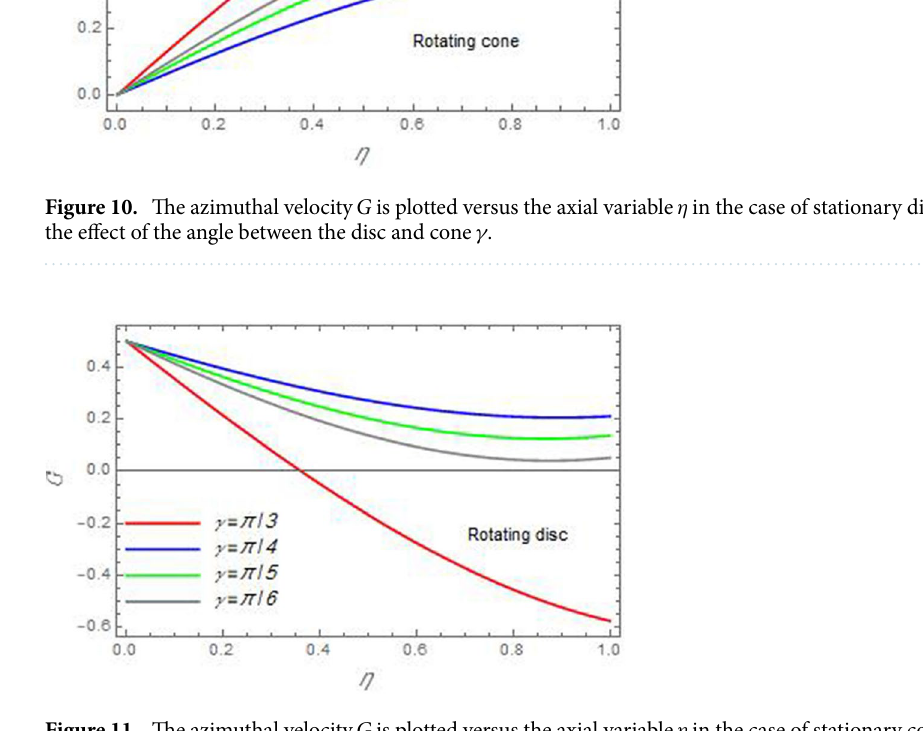
Figure 11. The azimuthal velocity G is plotted versus the axial variable η in the case of stationary cone to depict the effect of the angle between the disc and cone γ .